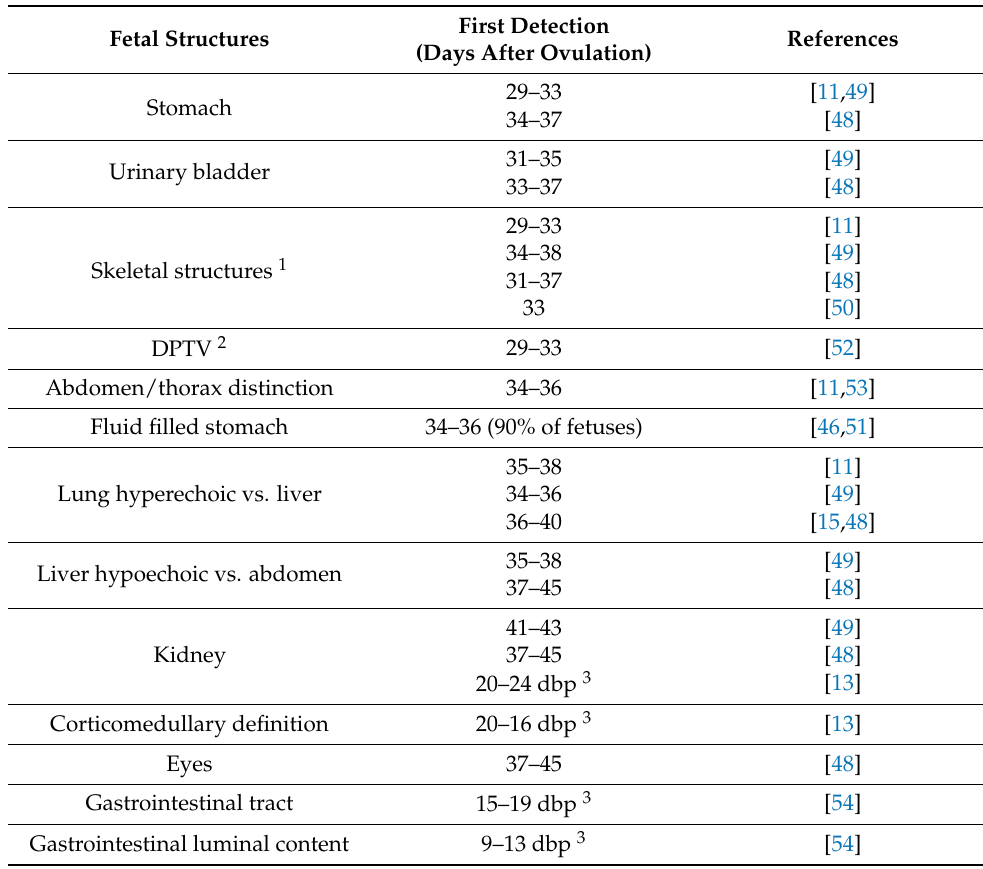
Table 2. Days of first appearance at ultrasound of fetal structures observed during the second half of pregnancy reported in literature and references.